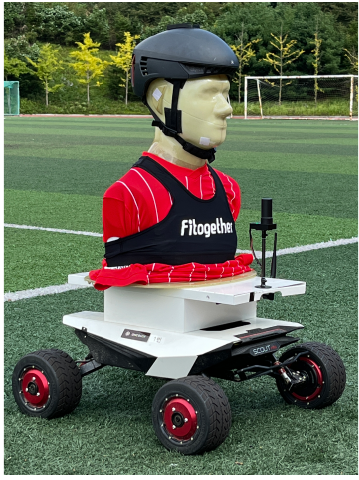
Figure 4. The rover equipped with a wearable EPTS.